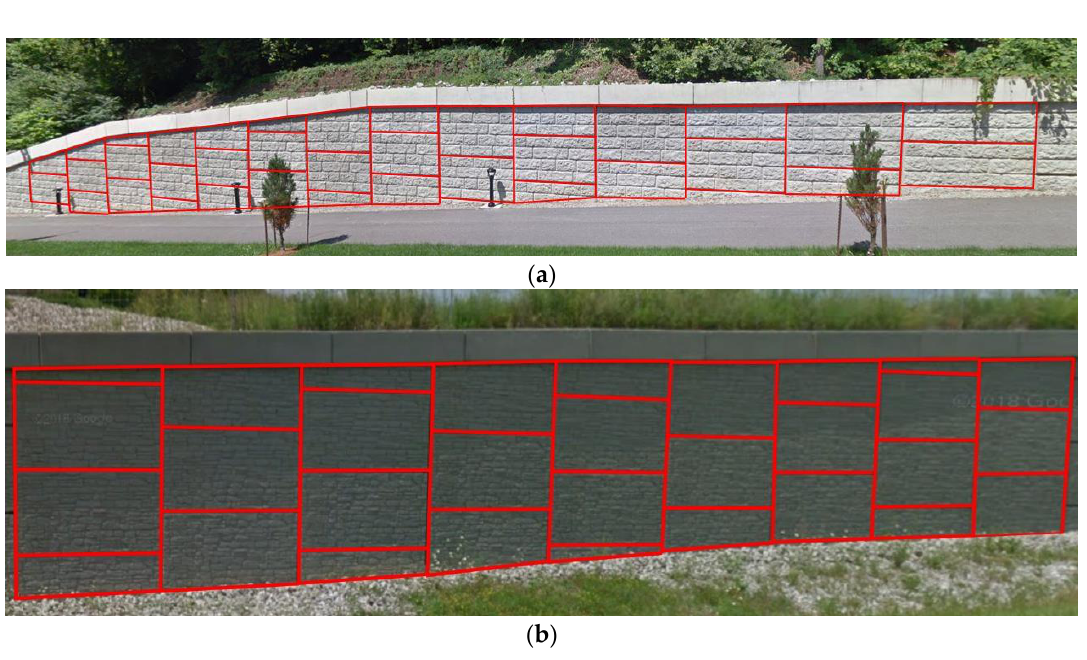
Figure 6. Sample photos of the textured MSE walls at different sites ( a ) Site-1 and ( b ) Site-2 (the different tiles are highlighted by the red rectangles).